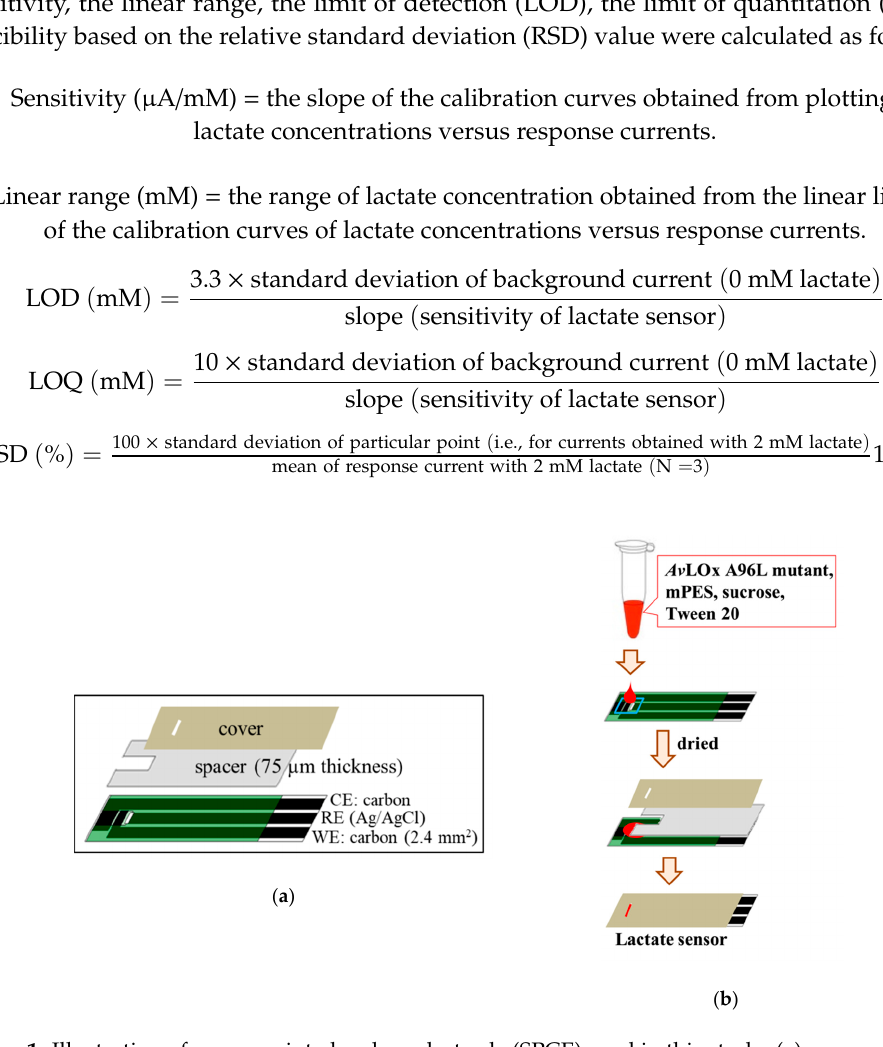
Figure 1. Illustration of screen-printed carbon electrode (SPCE) used in this study; ( a ) components of the SPCE and ( b ) construction of lactate